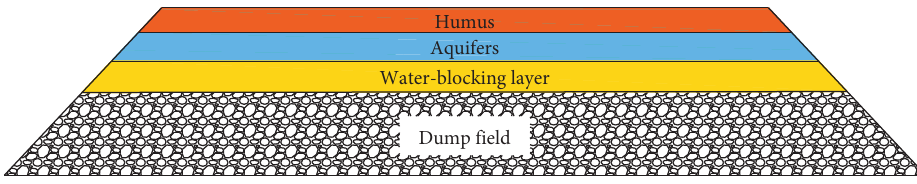
Figure 1: Distribution of reclamation strata in the dump sites.